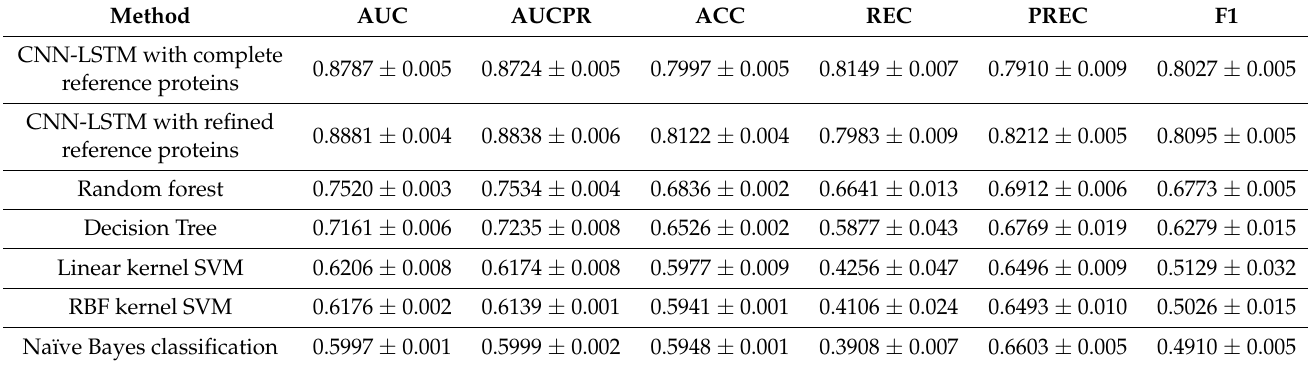
Table 1. The performance of CNN-LSTM with the refined reference proteins compared to the standard classifiers.